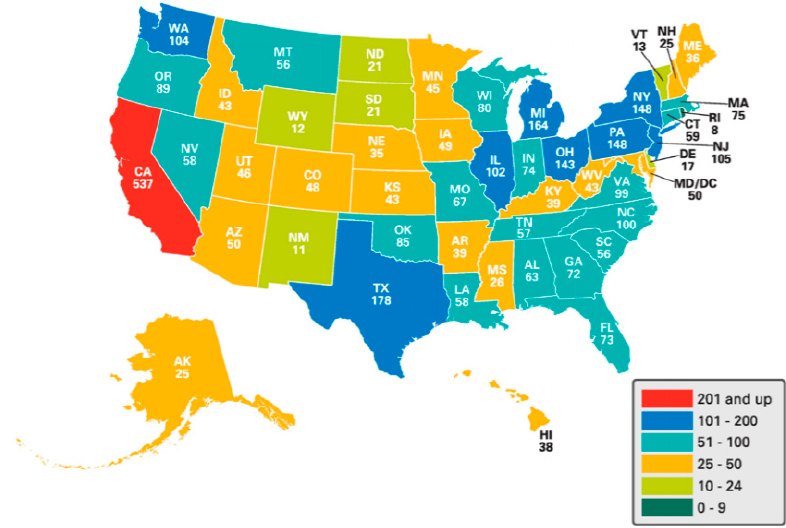
Figure 2. The number of power outage events in each state of the USA [17].